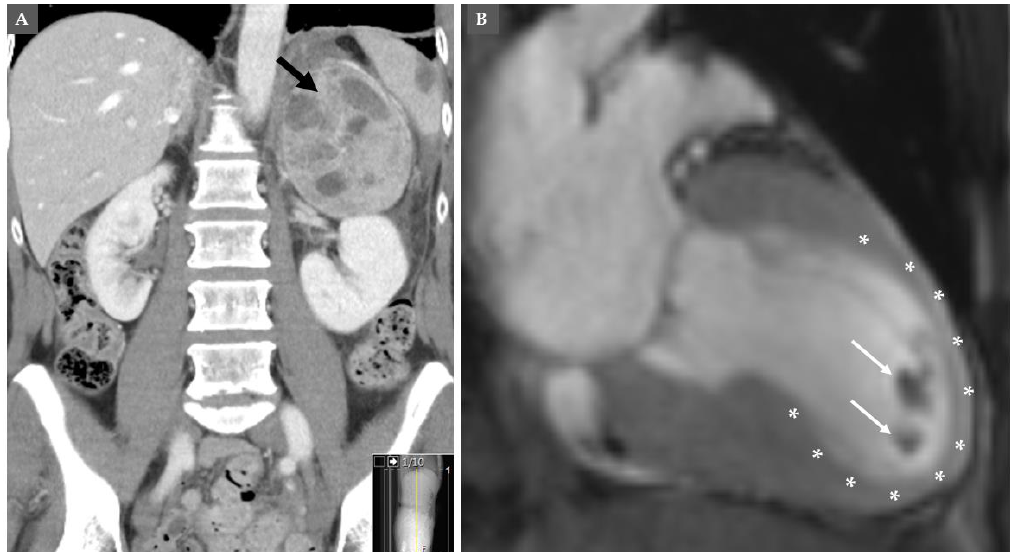
Figure 3. Computed tomography (CT) of the abdomen shows left-sided pheochromocytoma shown in ( A ) (black arrow). This pheochromocytoma has induced mid-apical pattern of takosubo syndrome (asterix), which was complicated by left ventricular thrombus at the apical region of the left ventricle (white arrows) as shown by cardiac magnetic resonance imaging in B .